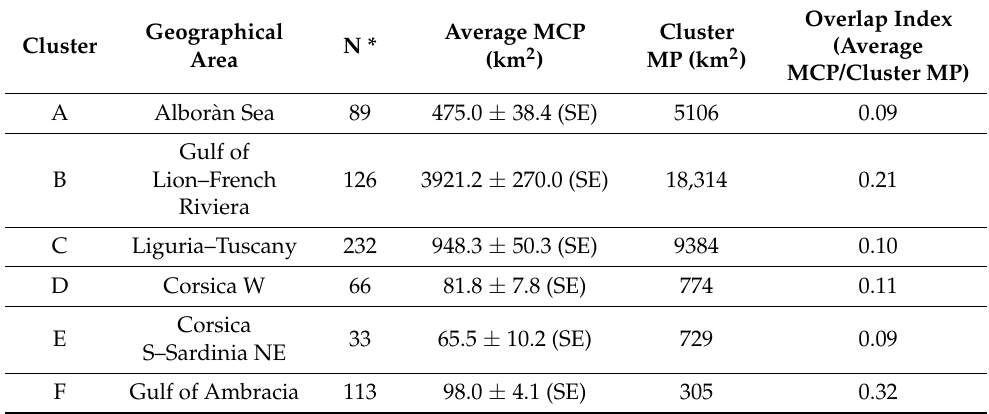
Table 5. The average area (km 2 ) of the individual MCPs and the area (km 2 ) of the multi-polygons (MPs) of each cluster. In the last column, the ratio between these two values was used to calculate the “overlap